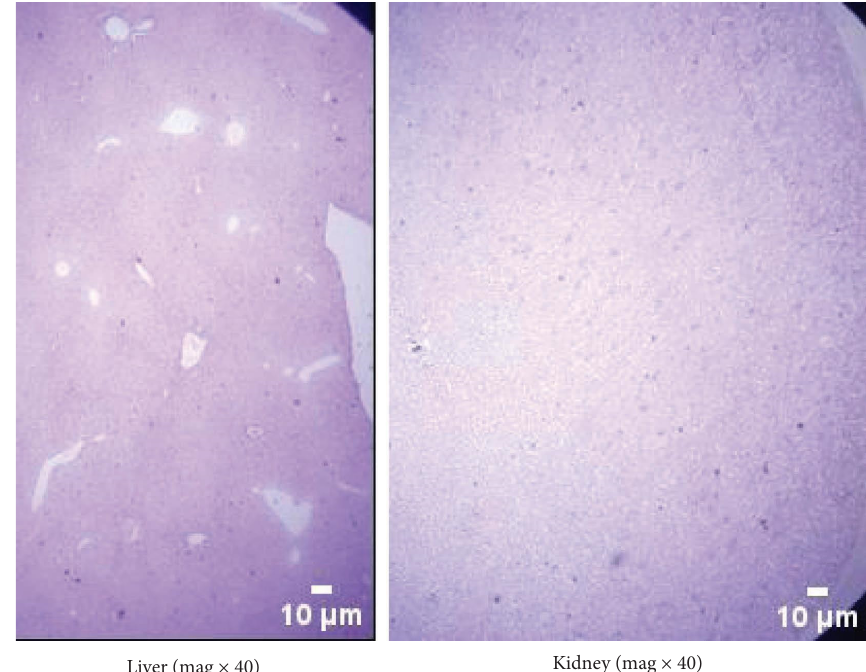
Figure 2: Histology of the liver and the kidney of mice treated at a dose of 500mg/kg indicating normal liver and kidney cells. (a) Liver (mag x40). (b) Kidney (mag x40).